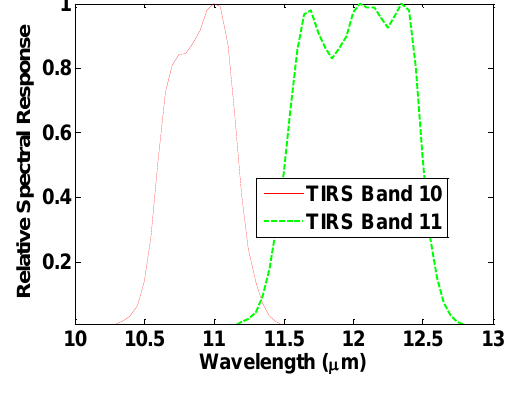
Figure 1. Landsat-8 TIRS bands’ relative spectral response functions (the data can be seen in